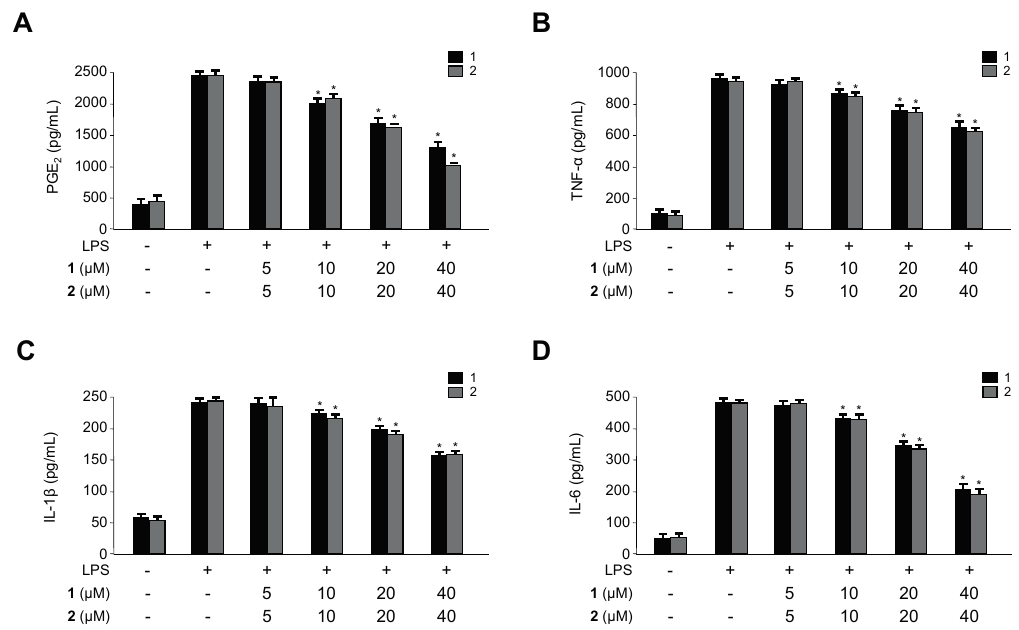
Figure 5. Effects of 1 and 2 on the production of prostaglandin E2 (PGE 2 ), tumor necrosis factor- α (TNF- α ), interleukin-1 β (IL-1 β ), and interleukin-6 (IL-6) ( A – D ) in RAW264.7 macrophages stimulated with lipopolysaccharide (LPS). RAW264.7 macrophages were pretreated with the indicated concentrations of 1 and 2 for 12 h, and then stimulated with LPS (1 μ g/mL) for 18 h. Data are represented as the mean ± S.D. of three independent experiments. * p < 0.05 vs. LPS treatment